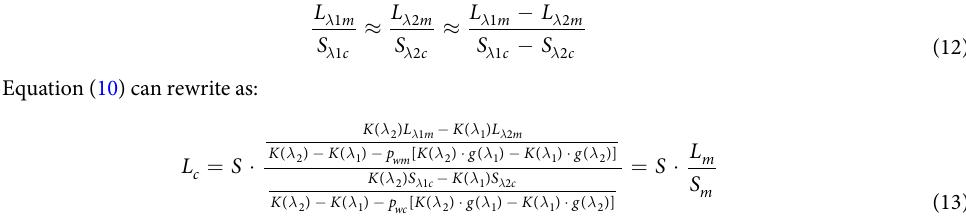
The temperature change consists of two parts. One is the direct influence of the constant, p w , and the other is the indirect influence of p w , with the constant ϕ . To simulate the accuracy of the two-color heterodyne laser interferometer with an uncertainty correction for the measured optical distance, it is assumed that the stage moves from 0 to 1500 mm with a velocity of 10 mm/s. The change in the atmospheric characteristics is generated randomly based on Table I and are shown in Fig. 2. Figure 2(a) displays the disturbance of the left optical path measurement before the stage mirror. Figure 2(b) shows the disturbance of the right optical path after the stage mirror. In 150 s, the change in the characteristics of the air is larger than reality and the difference between the left and right paths is also larger. The stability of the wavelength of the laser sources is typically ± 0.02 ppm in long-term measurements and ± 0.002 ppm in short term measurements. The laser fluctuations generated randomly are shown in Fig. 3. Where (a) is the red laser fluctuation, e laser 1 , with wavelength λ 1 = 0.6328 µ m and (b) is the blue laser fluctuation, e laser 2 , with wavelength λ using the red laser L λ 1 m and the blue line is the deviation of the measurement using the blue laser L λ 2 m . Generally, the deviation of the two colors is roughly identical because the deviations are caused mostly by disturbance of the air, and the two color measurement paths are combined to keep the environment the same. The measurement paths increase as the distance increases. The biggest deviation is 450 nm, which is 3 × 10 − 7 of the measured path length of 1500 mm. The deviations in the measurement of the two colors are not identical in this case. This is caused by the uncer- tainty in the measured optical distance. This will also cause uncertainty in the measurement using the two-color method. Figure 4(b) shows the uncertainty in each optical distance measurement, L λ 1 m and L λ 2 m , separate from Fig. 4(a). The red line is the uncertainty in the optical distance measurement using the red laser and the blue line is the uncertainty in the optical distance measurement using the blue laser. The uncertainties are mostly caused by the change in the wavelength. The biggest deviation is 30 nm, which is 2 × 10 − 8 of the measured path length of 1500 mm. Figure 5(a) shows the deviation caused by the uncertainties in measured optical distances. For the two-color method, the biggest deviation is 1200 nm, which is 0.8 × 10 − 6 of the measured path length of 1500 mm. So, even if each optical measurement error is small, their influence on the two-color method cannot be underestimated. Assuming that the correction arm length is equal to the overall length of the stage ( S = 1500 mm), Fig. 5(b) shows the comparison of the deviation of the measurement arm and the correction arm. The green line gives the deviation of the measurement arm and the cyan line gives the deviation of the correction arm. The ratio of the two measurement errors is equal to the ratio of the two lengths of the two arms. With the increase in distance, the deviations become close in value. The effect of the uncertainty in the humidity is not considered. The geometric distance is calculated using Equation (13), and the measurement error is shown in Fig. 6. The deviation is of the order of 10 − 4 nm, which is